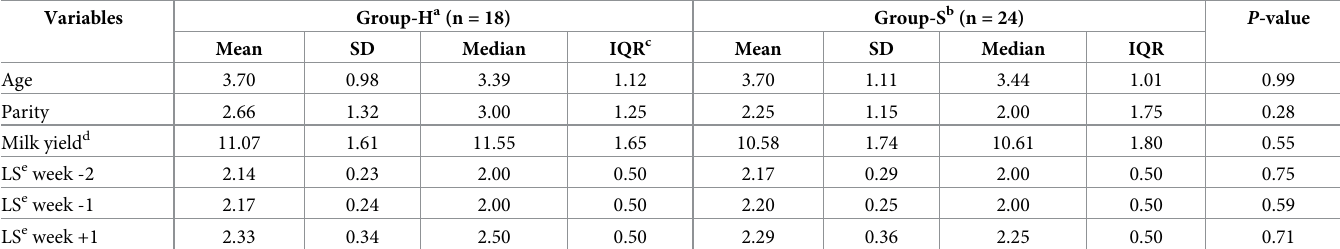
Table 1. Age, parity, milk yield and lamenss score of healthy cows) and those cows diseased during week +1 relative to calving. Variables Group-H a (n = 18) Group-S b (n = 24)